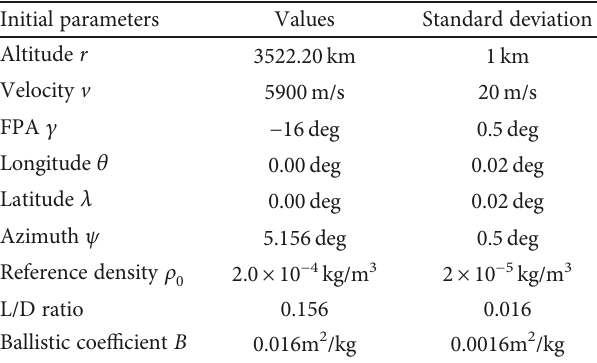
Table 2: Initial conditions and parameters during Mars entry.